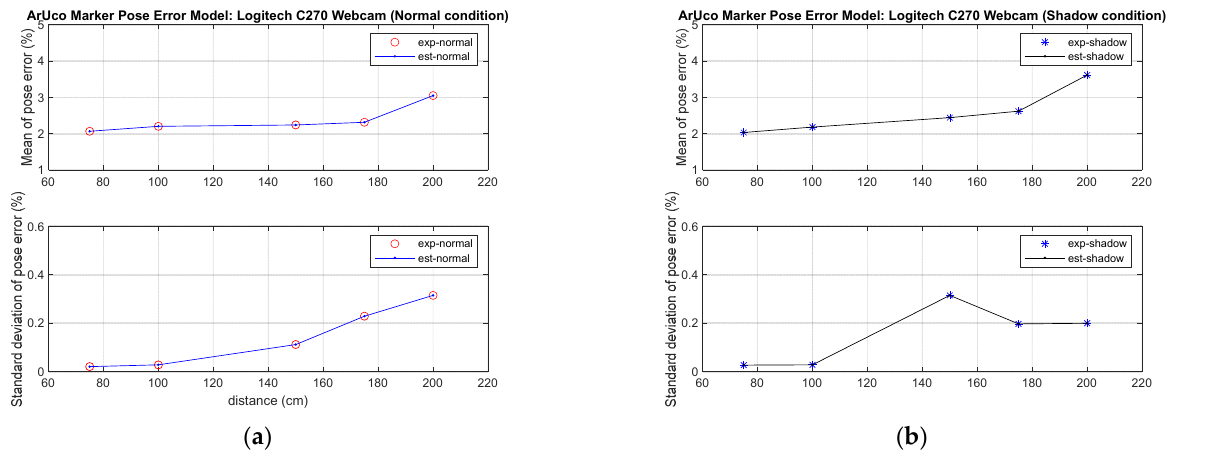
Figure 3. Position estimation error with relative distance: mean and standard deviation: ( a ) without shadow; ( b ) with shadow.